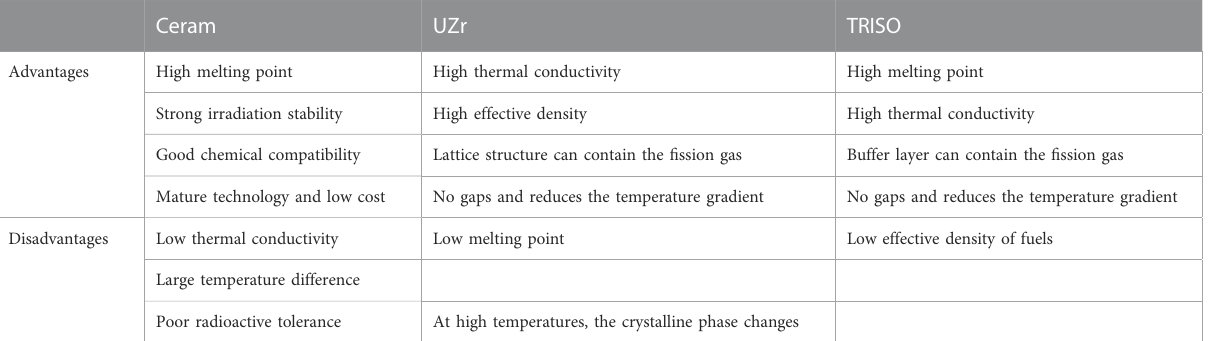
TABLE 1 Advantages and disadvantages of different pellet